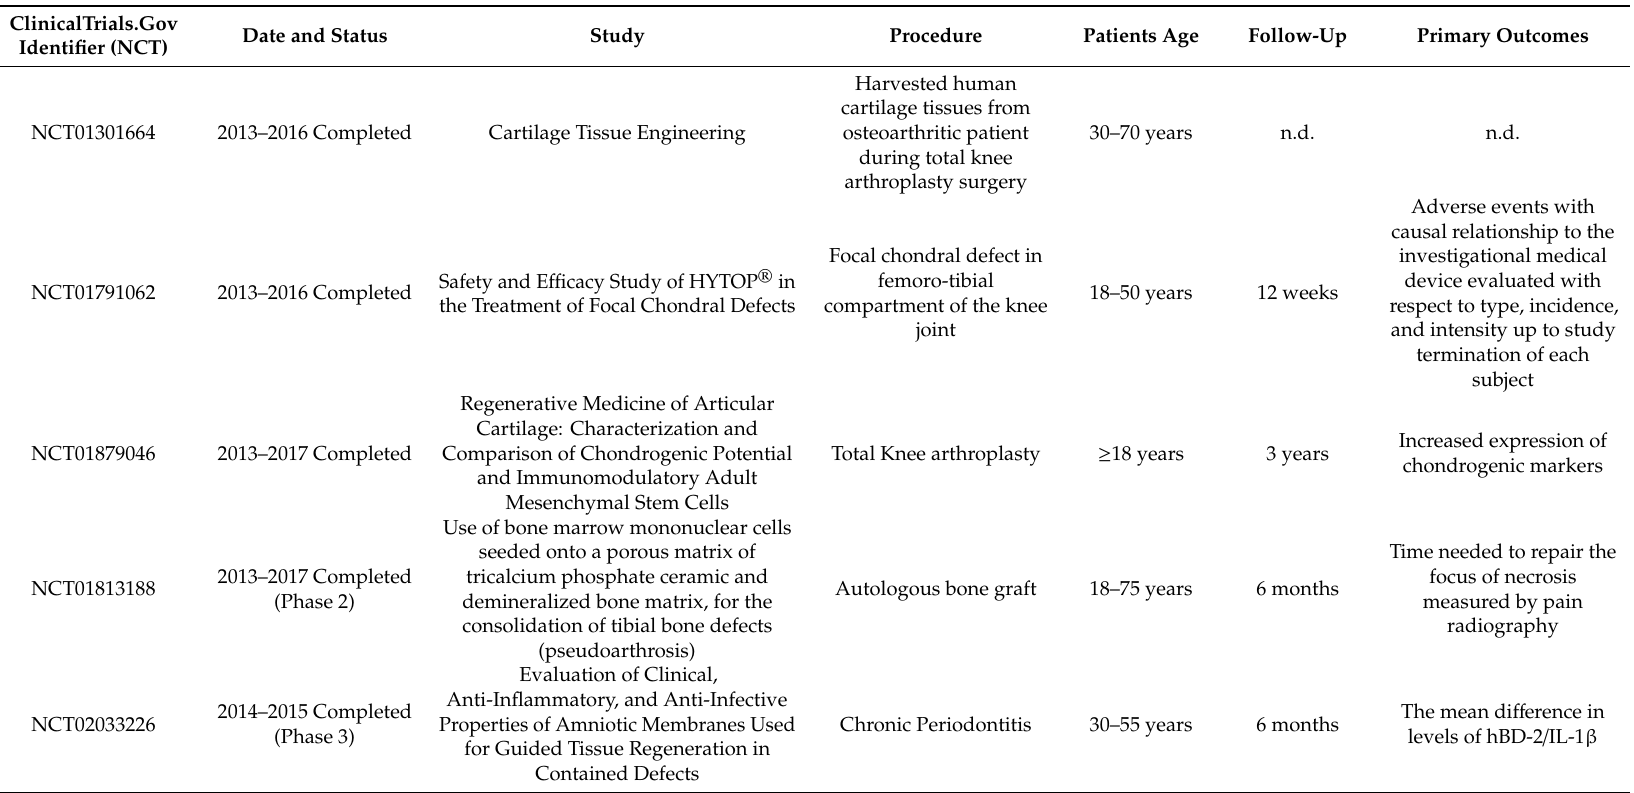
Table 3. Overview of the complete and ongoing clinical trials, in the last 5 years, using sca ff olds and hydrogel strategies for tissue engineering and regeneration. Information obtained from https: // clinicaltrials.gov /